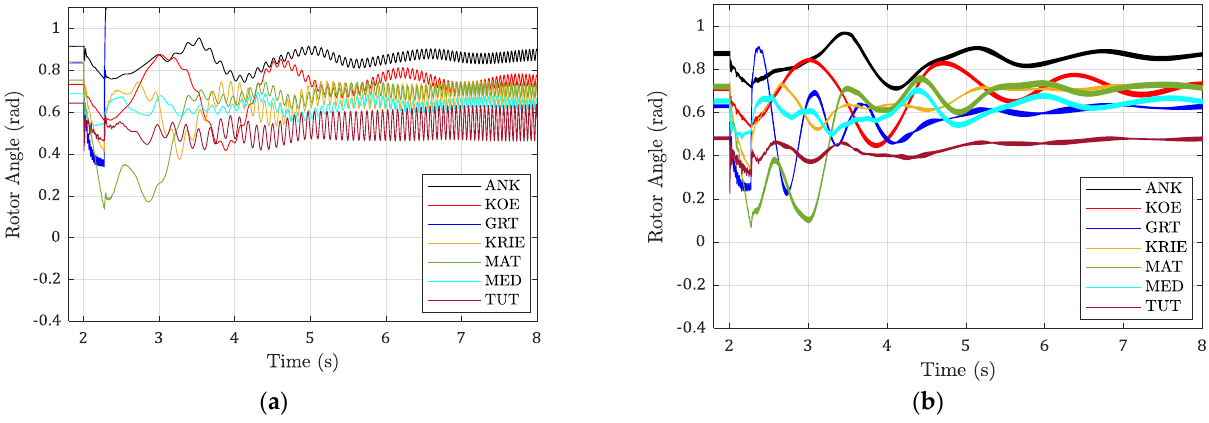
Figure 11. Rotor angle for the synchronous generator ( a ) without the MTDC link and ( b ) with the MTDC link.